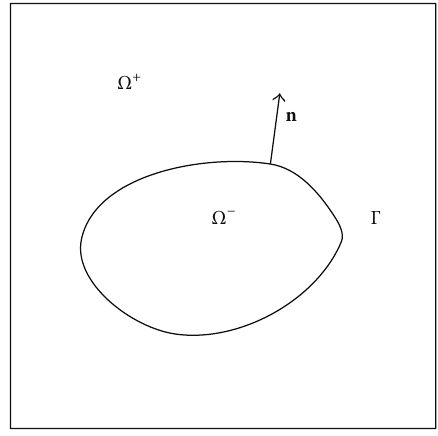
Figure 1: A domain Ω with